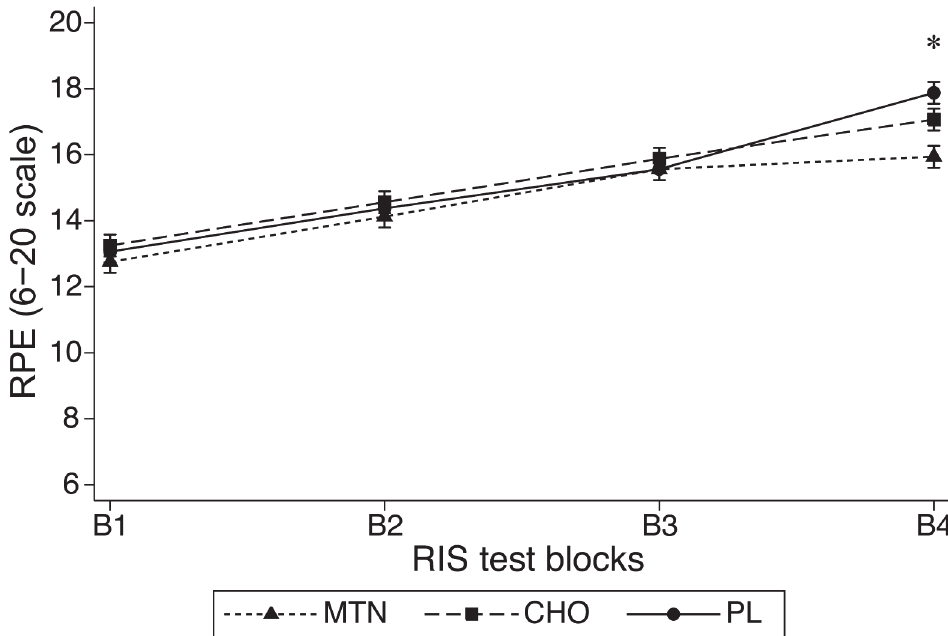
Fig 2. Rate of perceived exertion (RPE) values determined at the end of each block during the IRS test. * p > 0.01 from MTN to both placebo and CHO at the end of the 4 th block.